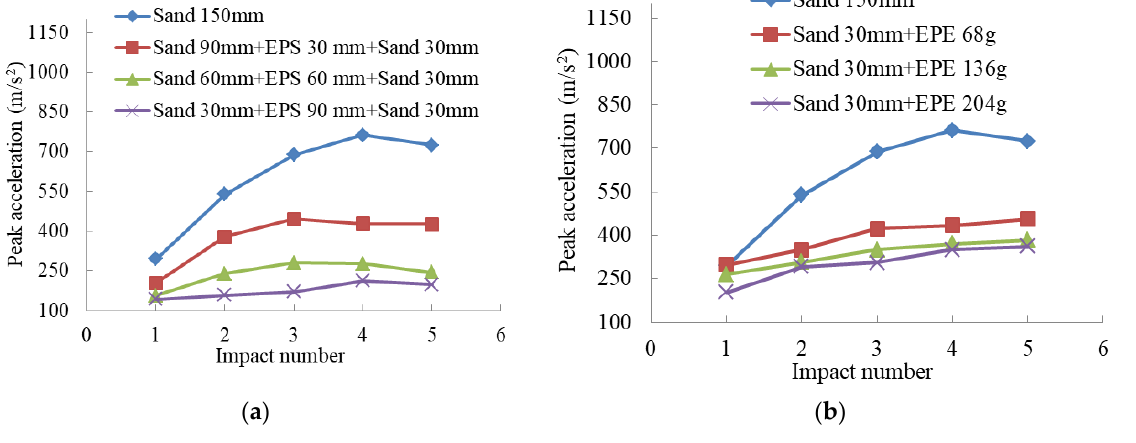
Figure 12. Peak acceleration curves of the sand–EPS and sand–EPE composite cushions with different geofoam quantity. ( a ) Sand–EPS cushion; ( b ) sand–EPE cushion. With the increase in the impact number, the peak acceleration was similar to that of the pure sand cushion, as shown in Figures 12 and 14. The peak acceleration gradually increased and tended to a constant value after the impact number reached five times.